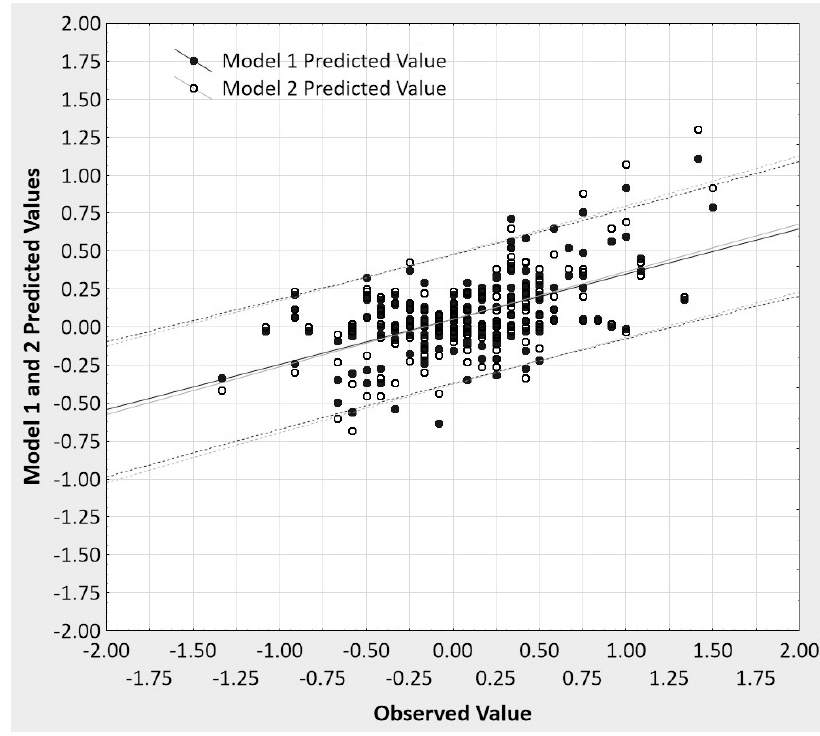
Figure 6. The observed vs. predicted values for each regression model, the two regression lines, and the 95% prediction intervals around each regression line (the dotted lines).